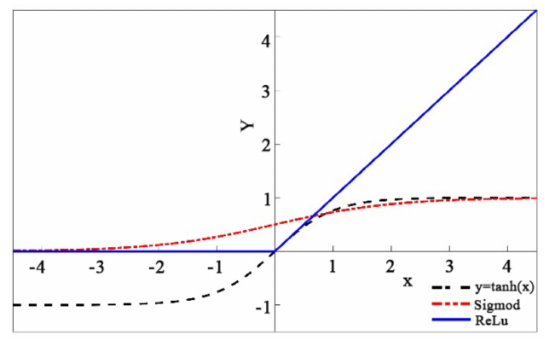
Figure 5. Activation